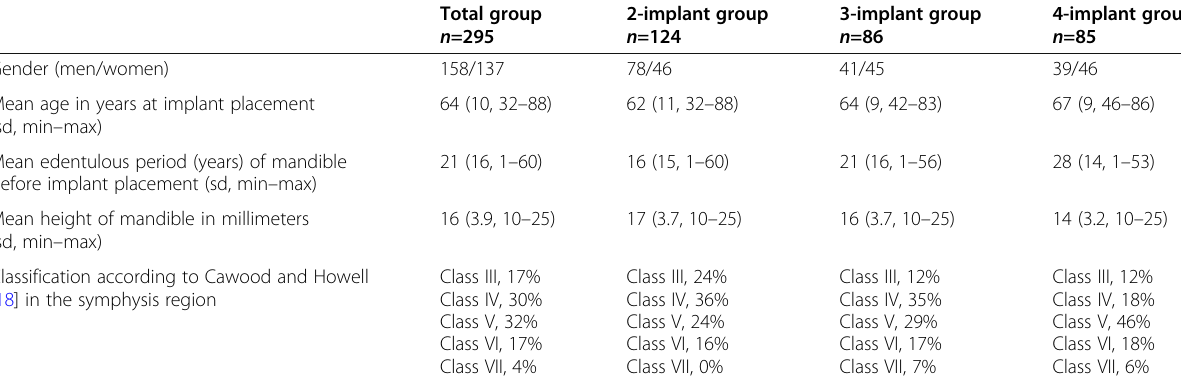
Table 1 Patient characteristics of total group and of patients with two, three, or four implants